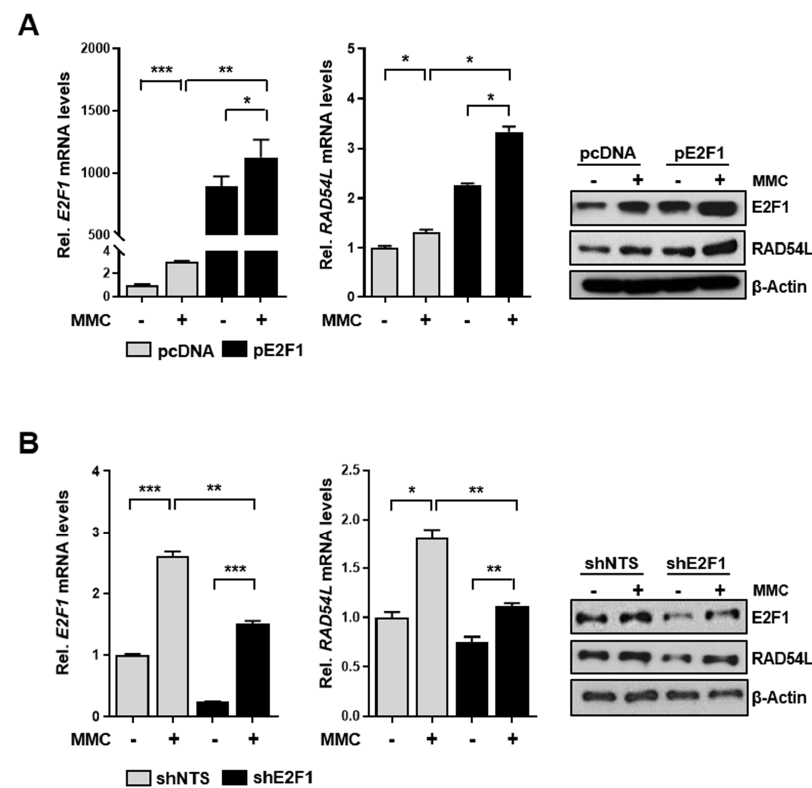
Figure 4. RAD54L expression is induced in MMC-treated cells with E2F1 overexpression or knockdown. ( A ) Cells were incubated without or with 10 µ M MMC for 4 h and allowed to recover for up to 24 h. Expression of E2F1 and RAD54L mRNAs and proteins in E2F1 transfected-5637 cells and in ( B ) EJ cells with a stable knockdown of E2F1 (shE2F1, control cells; shNTS) were analyzed by qRT-PCR and western blot, respectively. Data are presented as mean ± SD.*, P < 0.05; **, P < 0.01; ***, P <